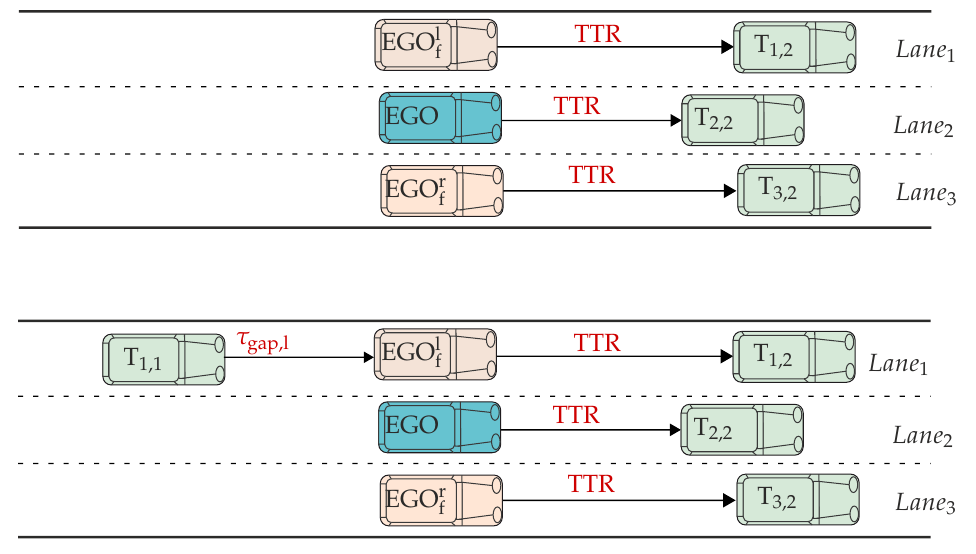
Figure 5. Graphical representation of test scenarios. Table 3. Initial states and parameters for the test